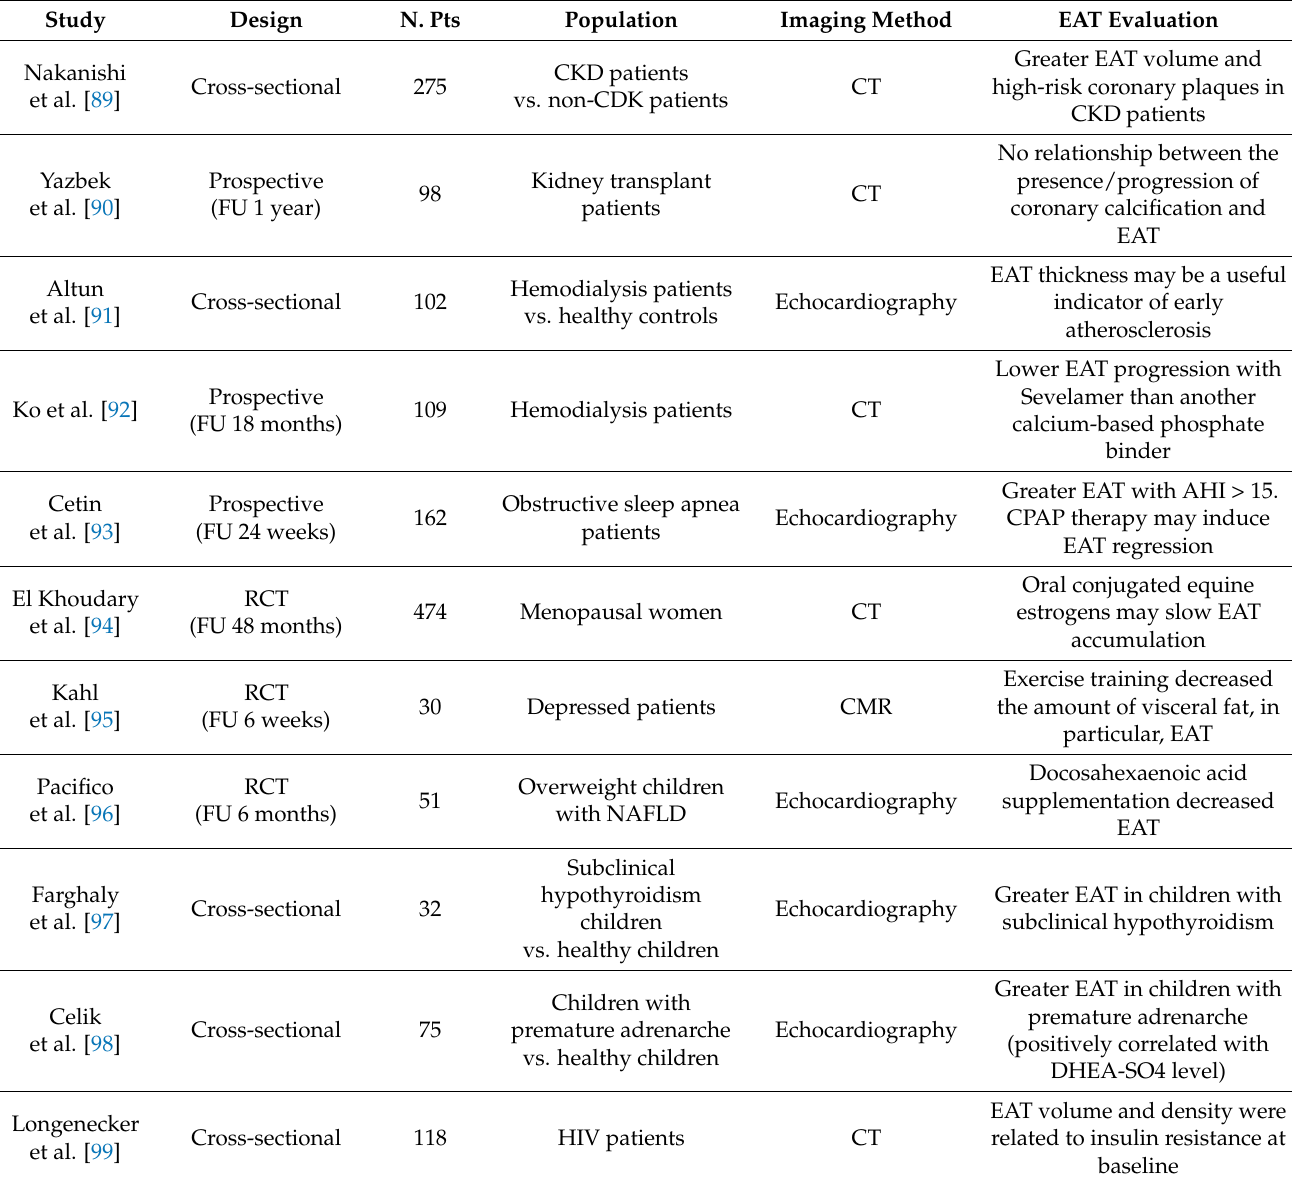
Table 3. Epicardial adipose tissue evaluation in some specific clinical